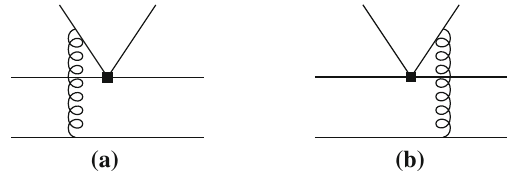
Fig. 1 The spectator scattering